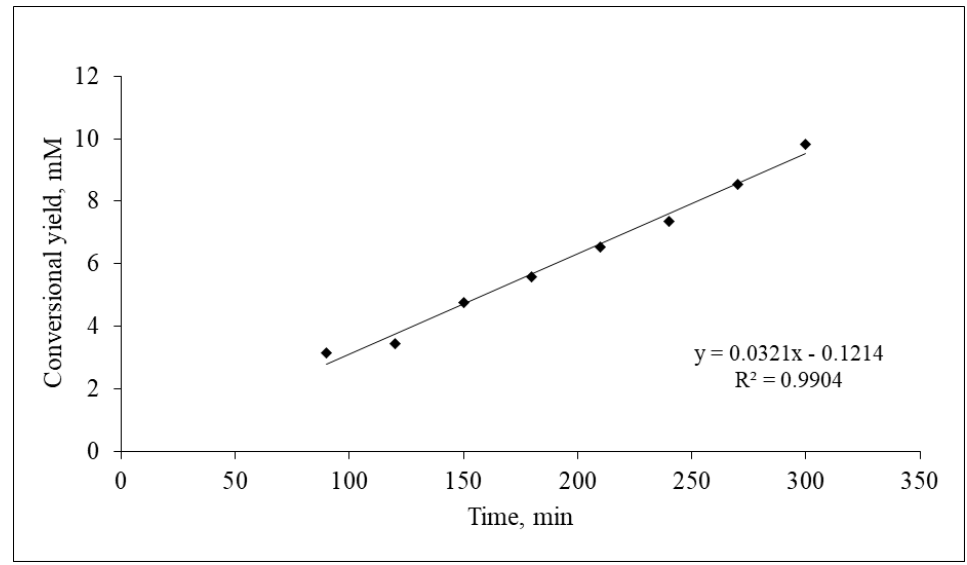
Figure 1. Reaction profile, for up to six hours, of the esterification of 1-propanol with lauric acid (100 mM, each) catalyzed by M. miehei lipase immobilized on HPMC:chitosan film (2:1 ratio). Lipase concentration, 0.3 mg/g of film; 10 mL of isooctane as solvent, at room temperature.